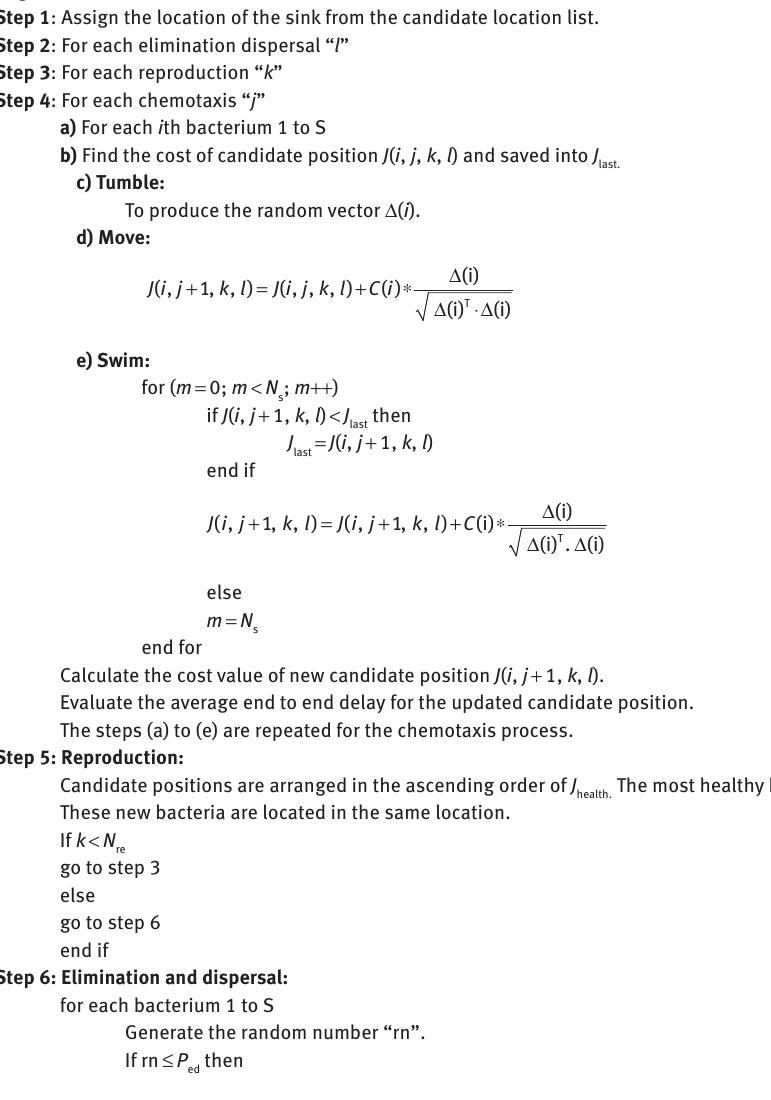
Algorithm 2: Multiple sink placement problem using Bacteria Foraging Algorithm